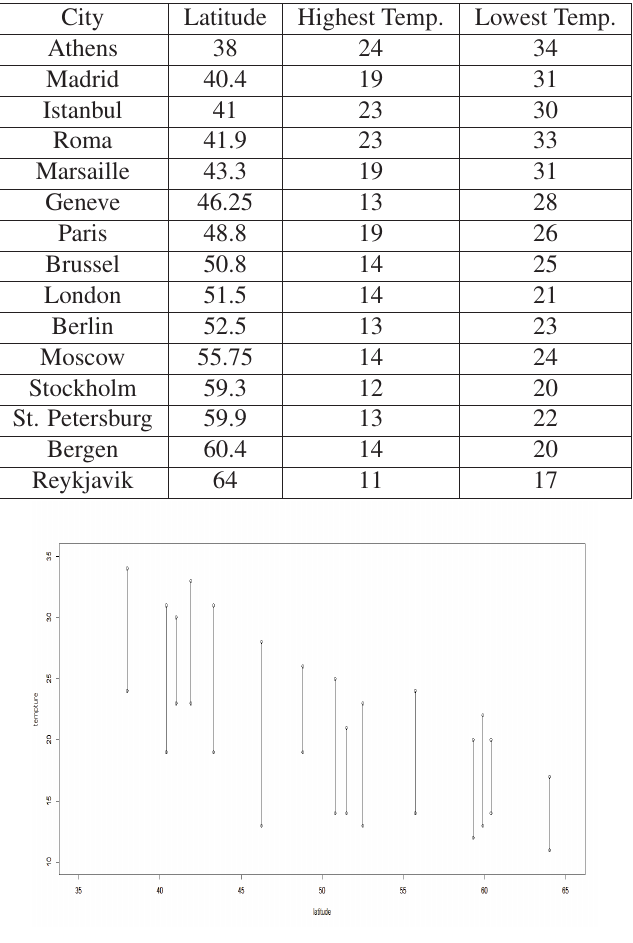
Fig. 3. Temperatures (in the form of interval) and latitudes of 15 European cities. Each line segment represents the temperature interval of each